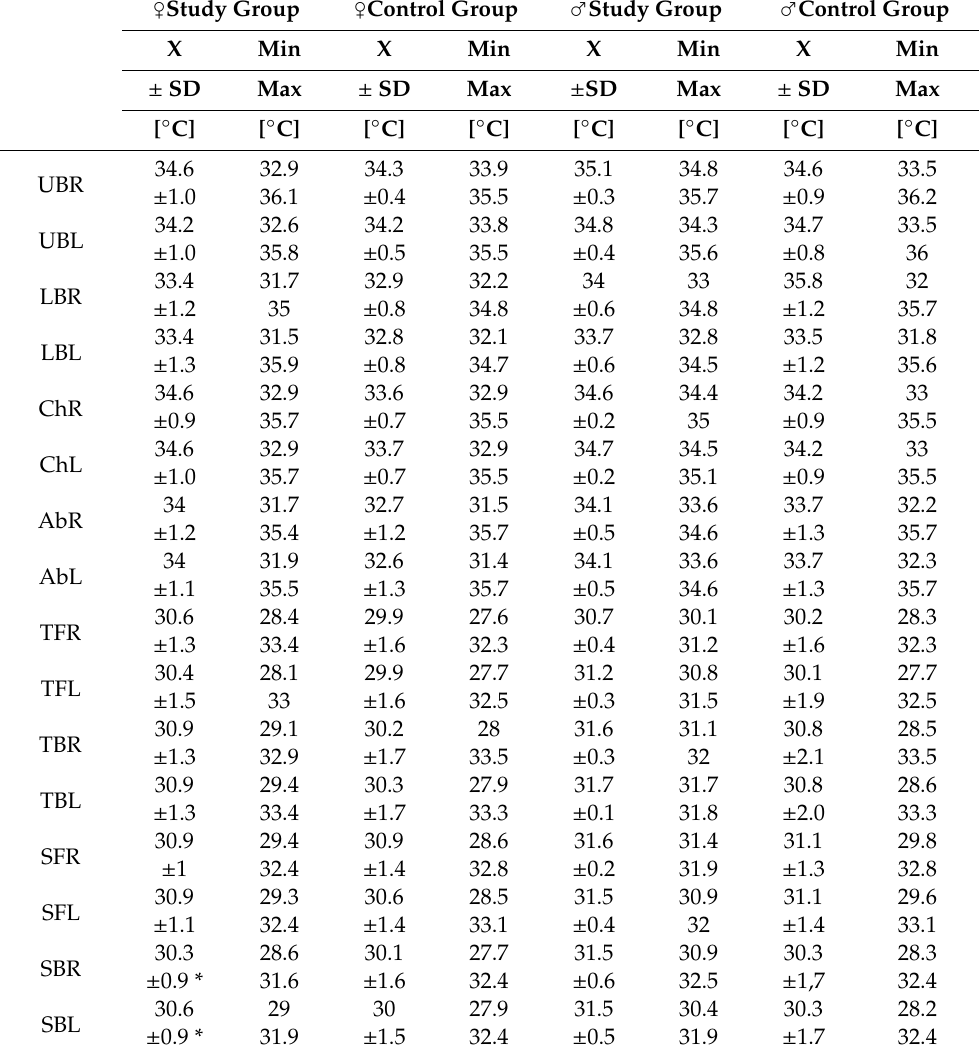
Table 2. Mean, minimum, and maximum values for the temperatures of selected body areas in girls and boys with scoliosis, taking into account the di ff erences between the sexes within the groups. Study Group Control Group Study Group Control Group ♀ ♀ ♂ ♂ X Min X Min X Min X